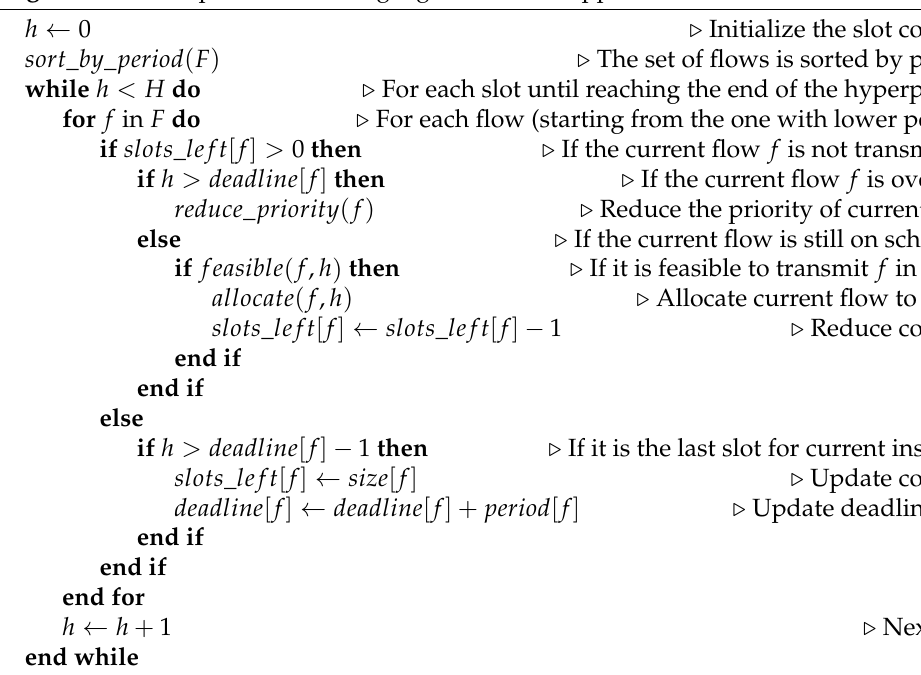
Algorithm 1 First phase scheduling algorithm: first